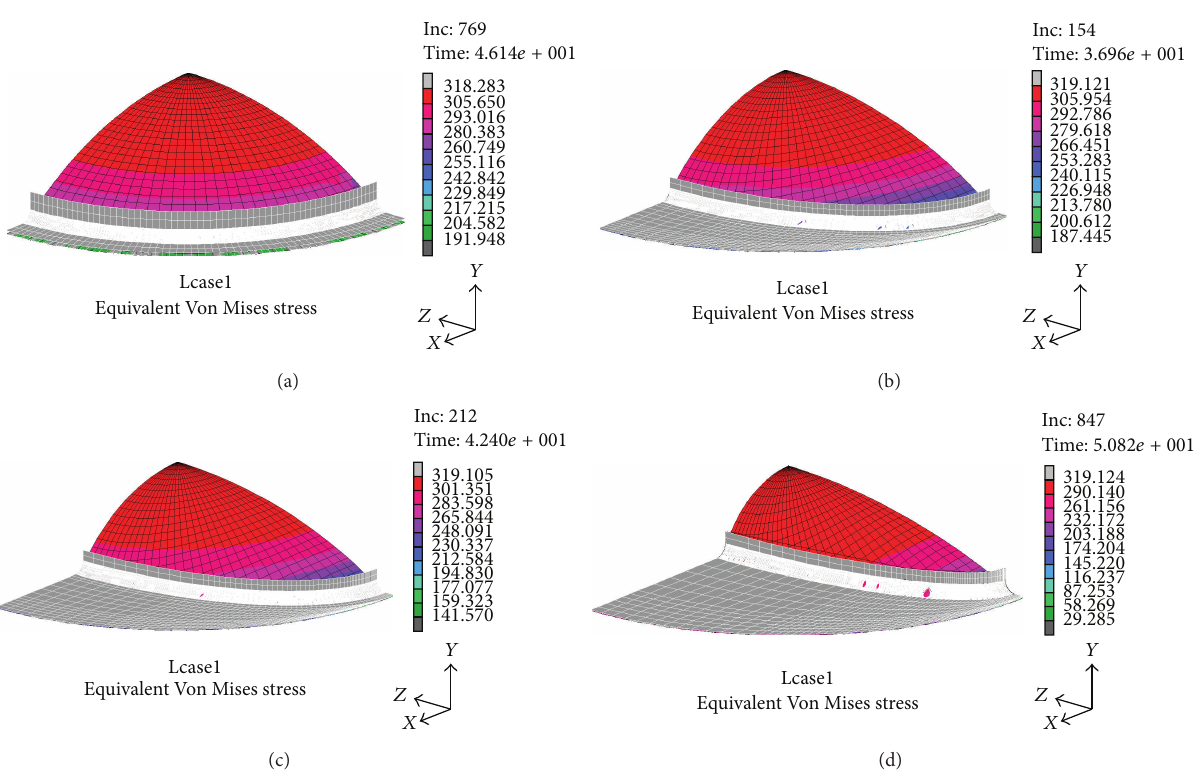
Figure 27: Von Mises stress distribution for the CS1 condition in MSC-MARC. (a) Circular. (b) 10 × 7 ellipse. (c) 10 × 6 ellipse. (d) 10 × 4 ellipse.